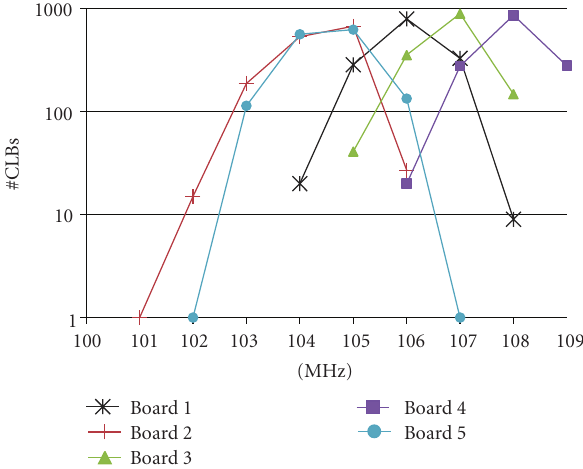
Figure 10: Distribution of OSC speed board 1–5.